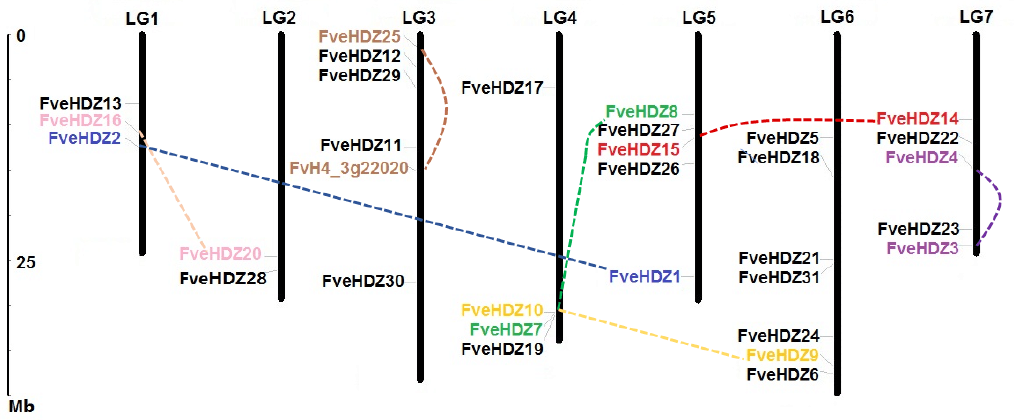
Figure 2. Physical locations of FveHDZs on F. vesca chromosomes. Chromosome numbers were indicated at the top of each chromosome. The scale at the left represented the length of the chromosome. Seven pairs of FveHDZs connected by dash lines with different colors resulted from WGD/segmental duplication. FvH4_3g22020 was classified to be a WGD/segmental duplicate gene with FveHDZ25 by the MCscanX analysis, but was not included in the HD-Zip family as its coding protein did not contain the HD domain and LZ motifs in the N terminus (Figure S3).